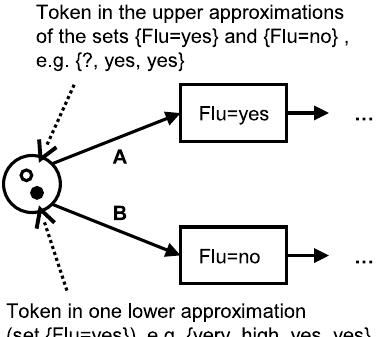
Fig. 5. Tokens in Lower and Upper